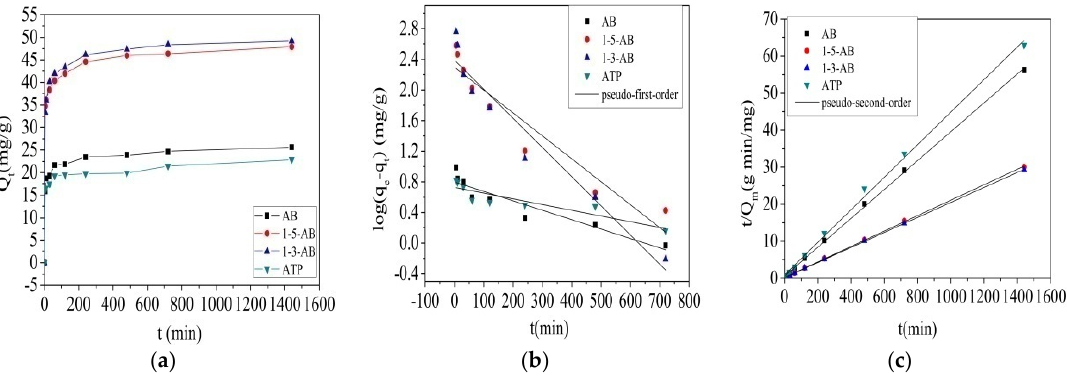
Figure 7. Kinetics spectra for the sorption of RBR on the three biochar samples: ( a ) effect of contact time on RBR adsorption capacity of the biochar samples, ( b ) pseudo ‐ first ‐ order model, and ( c ) pseudo ‐ second ‐ order model (biochar dosage, 0.1 g; temperature, 25 °C; t , 1440 min; initial pH, 6.0–7.0).